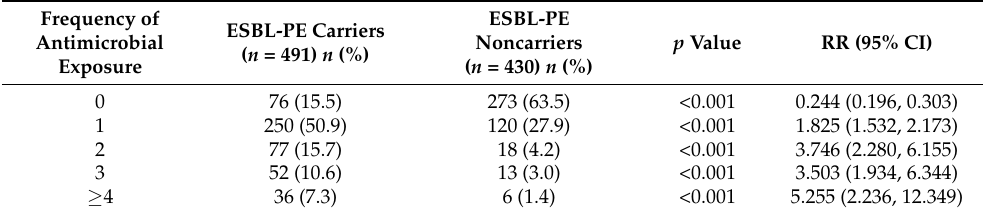
Table 4. Correlation between the frequency of intestinal ESBL-PE carriage and antimicrobial exposure during the 9 months prior to sample collection.